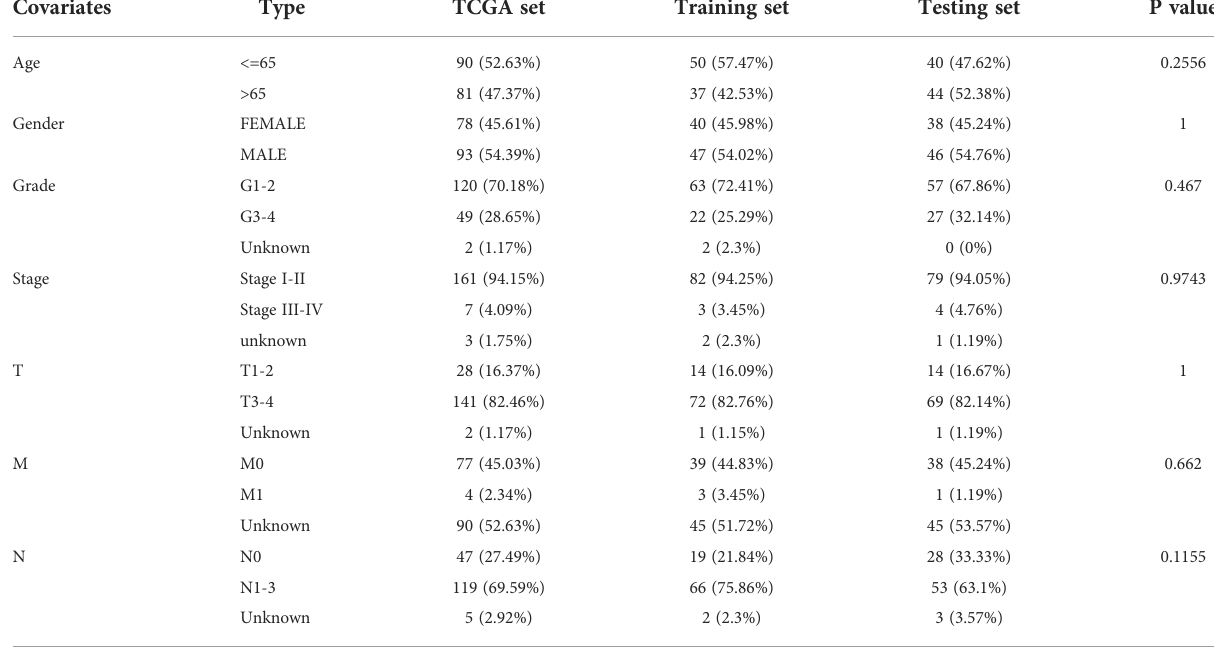
TABLE 1 Clinical information for three TCGA patients sets in this study.